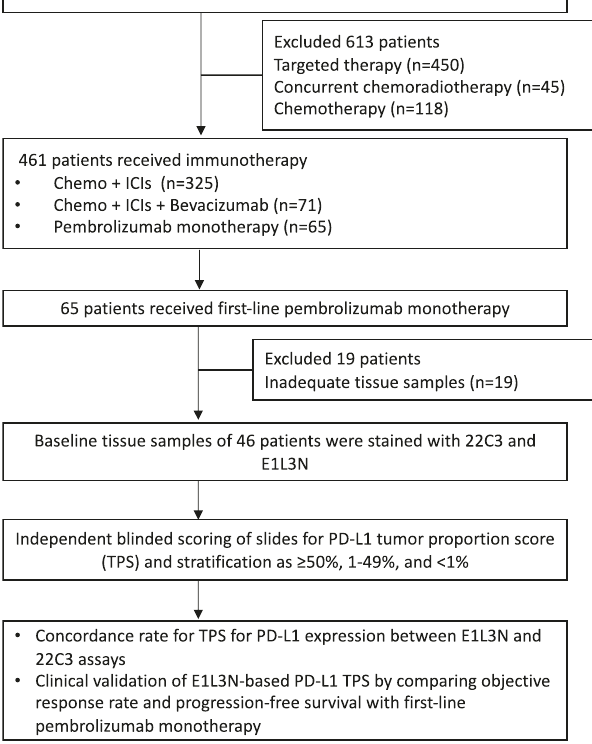
Fig. 1 Flow chart of the study cohort. Abbreviation: Chemo + ICI chemotherapy plus immune checkpoint inhibitor therapy; TPS tumor proportion